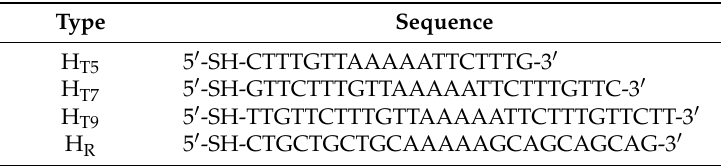
Table 1. Oligonucleotide Sequences Used in This Work a